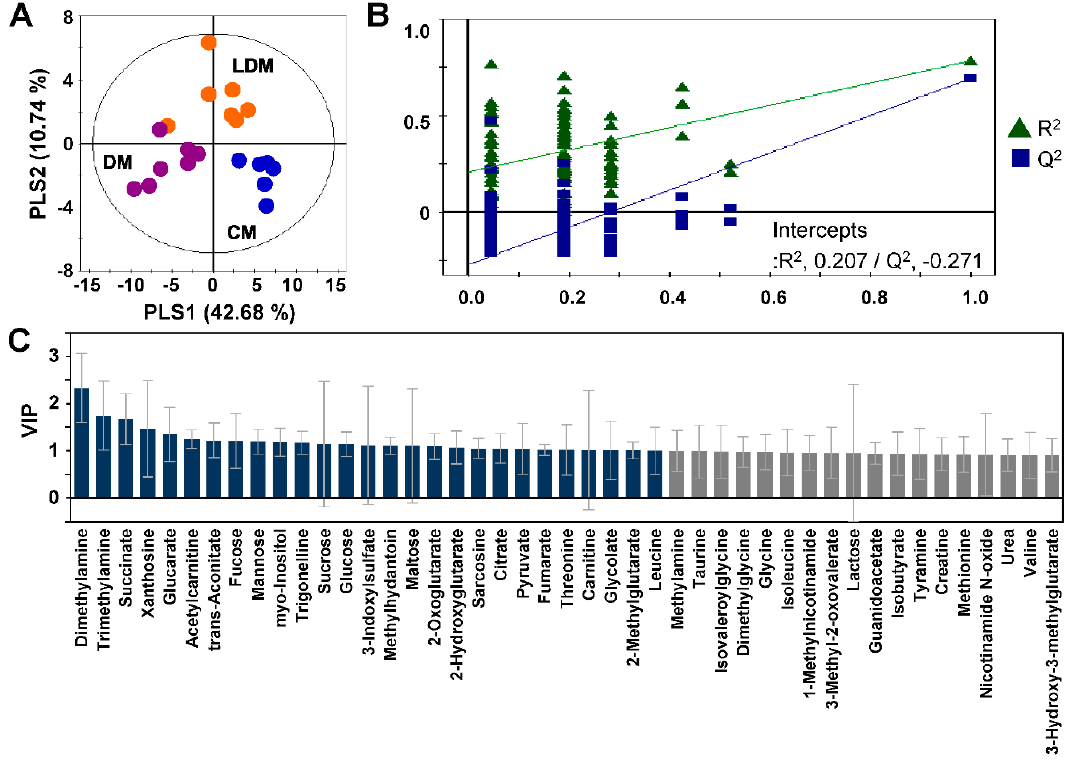
Figure 2. PLS-DA score plot of targeted metabolic profiles of mouse urine. The PLS-DA score plot ( A ) shows perturbation of metabolic patterns in CM (blue dots), DM (violet dots), and LDM (orange dots). Validation plots of urine ( B ) were obtained from 100 permutation tests of the responses to the PLS-DA models. Identified metabolites that have high VIP scores are presented in the bar graph ( C ) in gray (VIP > 0.9) or dark blue (VIP > 1.0). PLS-DA, partial least squares discriminant analysis, CM,